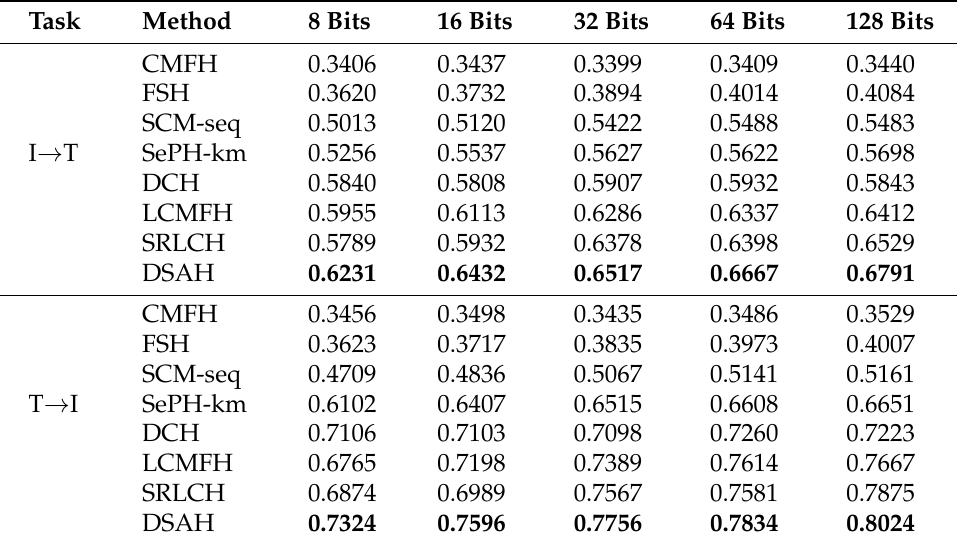
Table 3. Performance comparison on NUS-WIDE dataset measured by mAP.